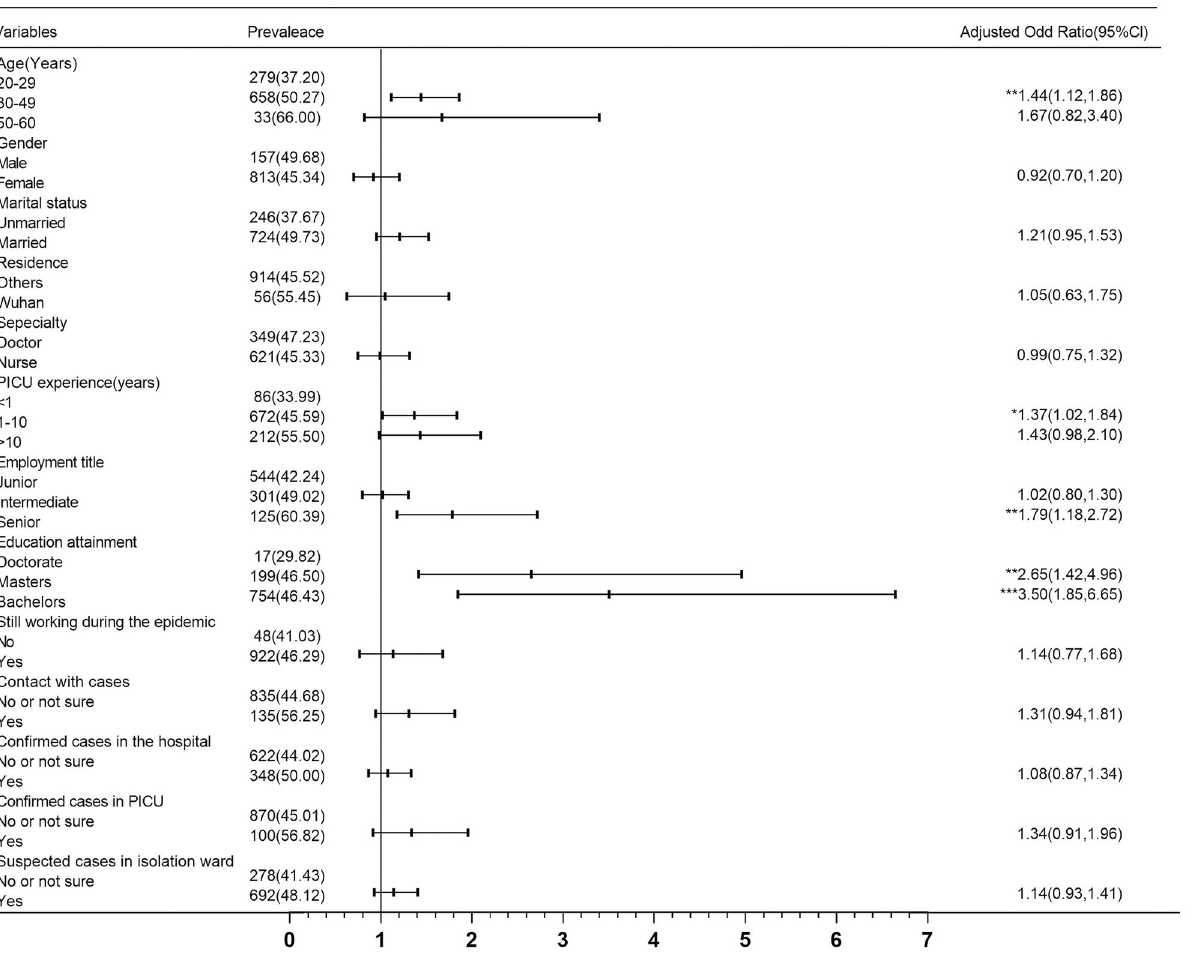
Fig 2. Multivariable logistic regression models for post-traumatic distress (IES-R � 24) (n = 2109).